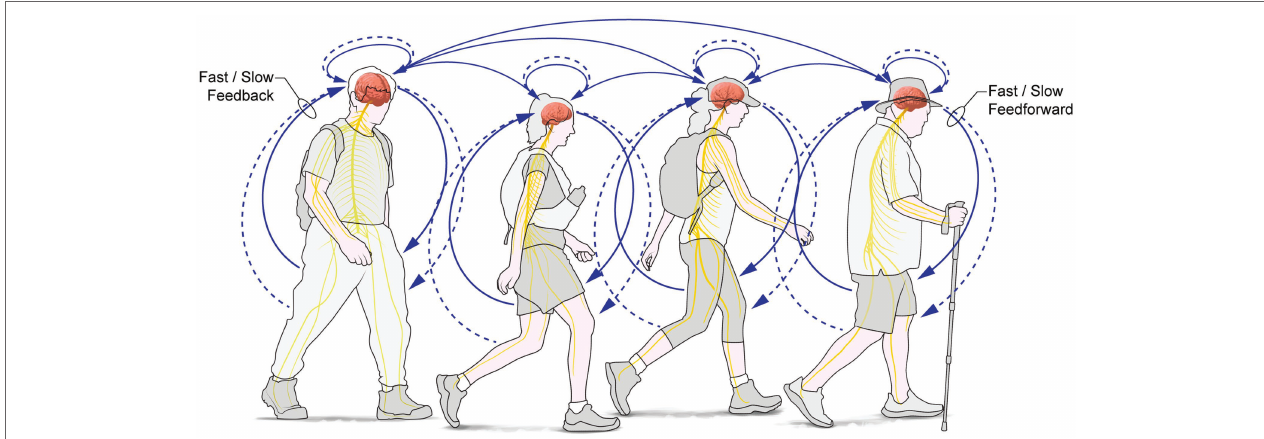
FIGURE 2 | Social: During PW, intrapersonal processes reciprocally support interpersonal social connectedness, social relationships and social synchronisation (with those physically or psychologically or both, present); these are built on underpinning, consolidating and supporting changes in brain and